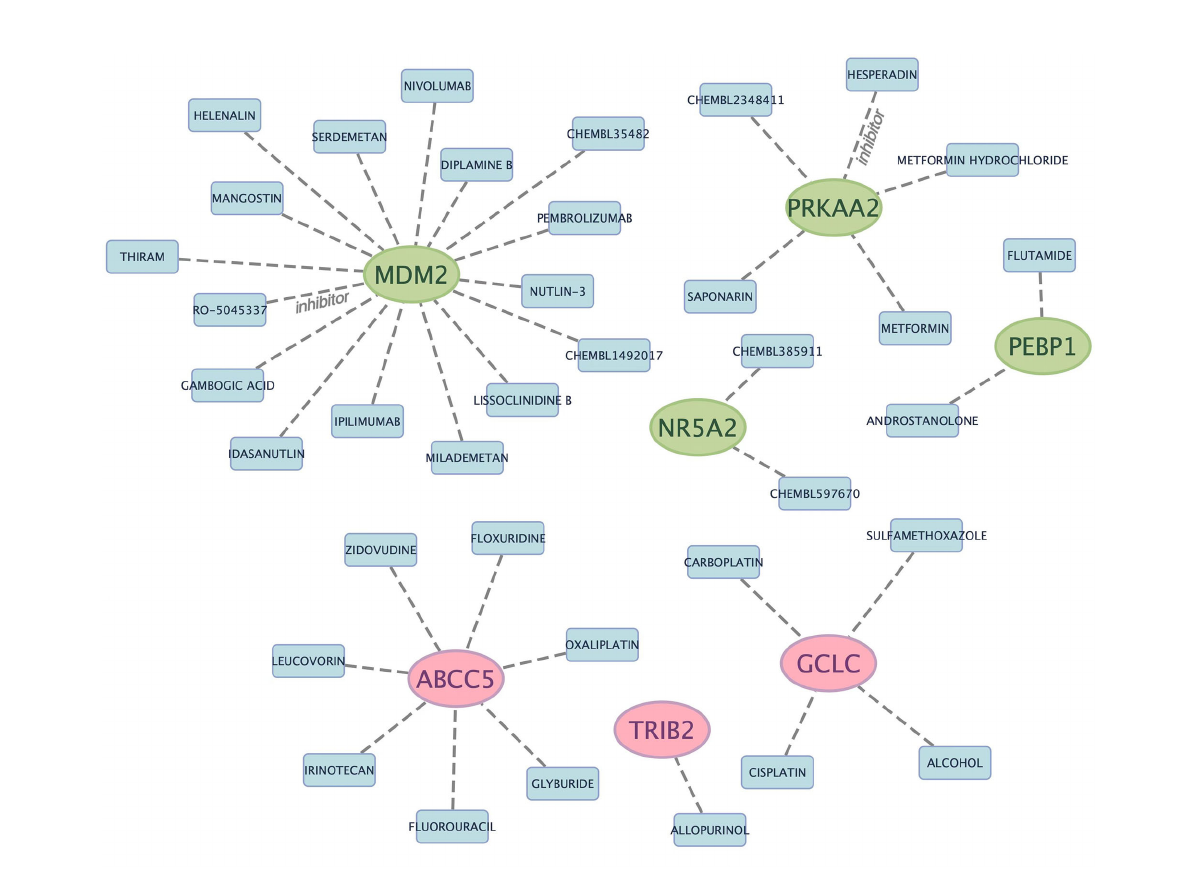
FIGURE 4 Prediction of marker gene-targeted drugs. The drugs may target marker genes through the DGIdb database and the interaction relationship between the